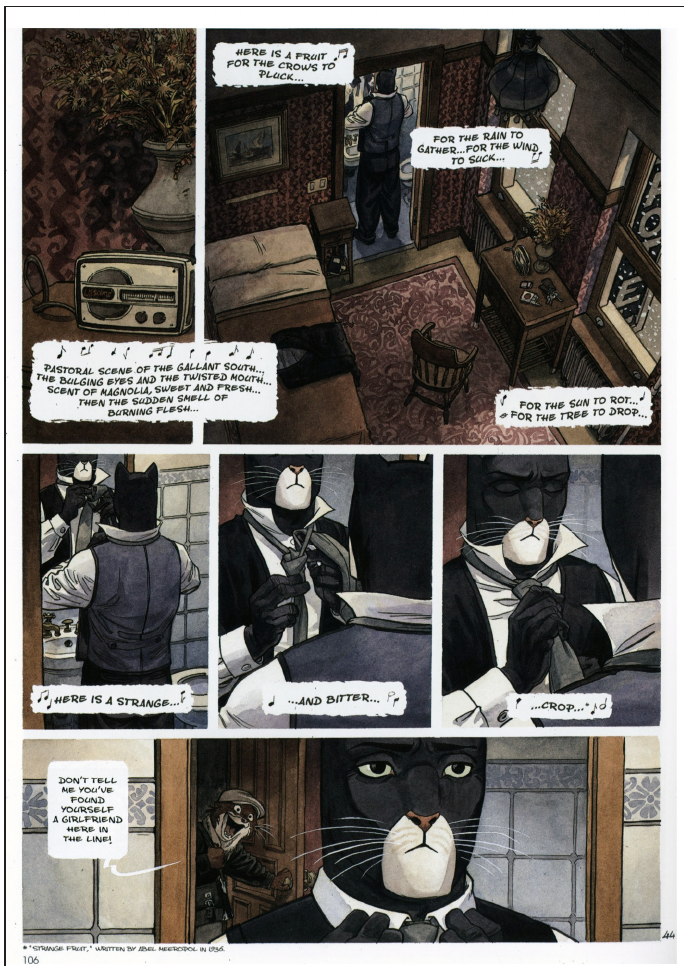
Figure 2: Juan Díaz Canales and Juanjo Guarnido, Blacksad , 2010, Dark Horse Books, p.